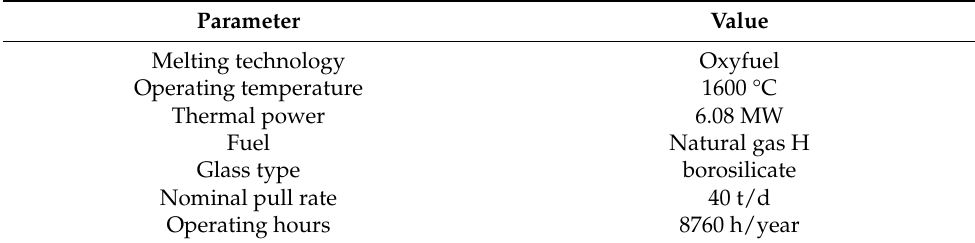
Table 1. Key figures of the melting system investigated in